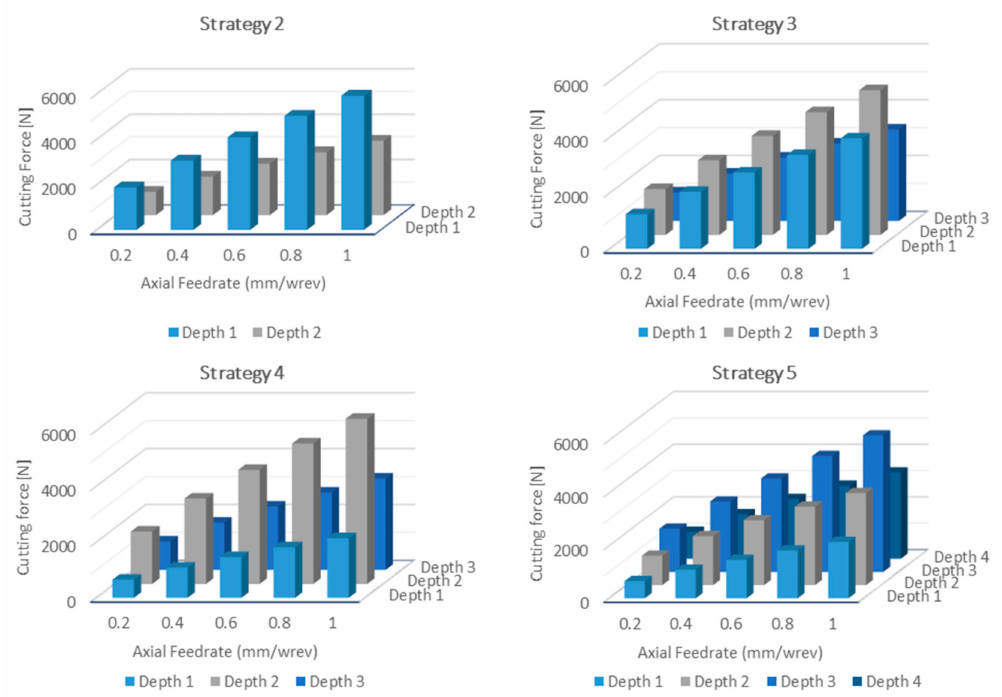
Figure 11. Cutting force Z component for each strategy.